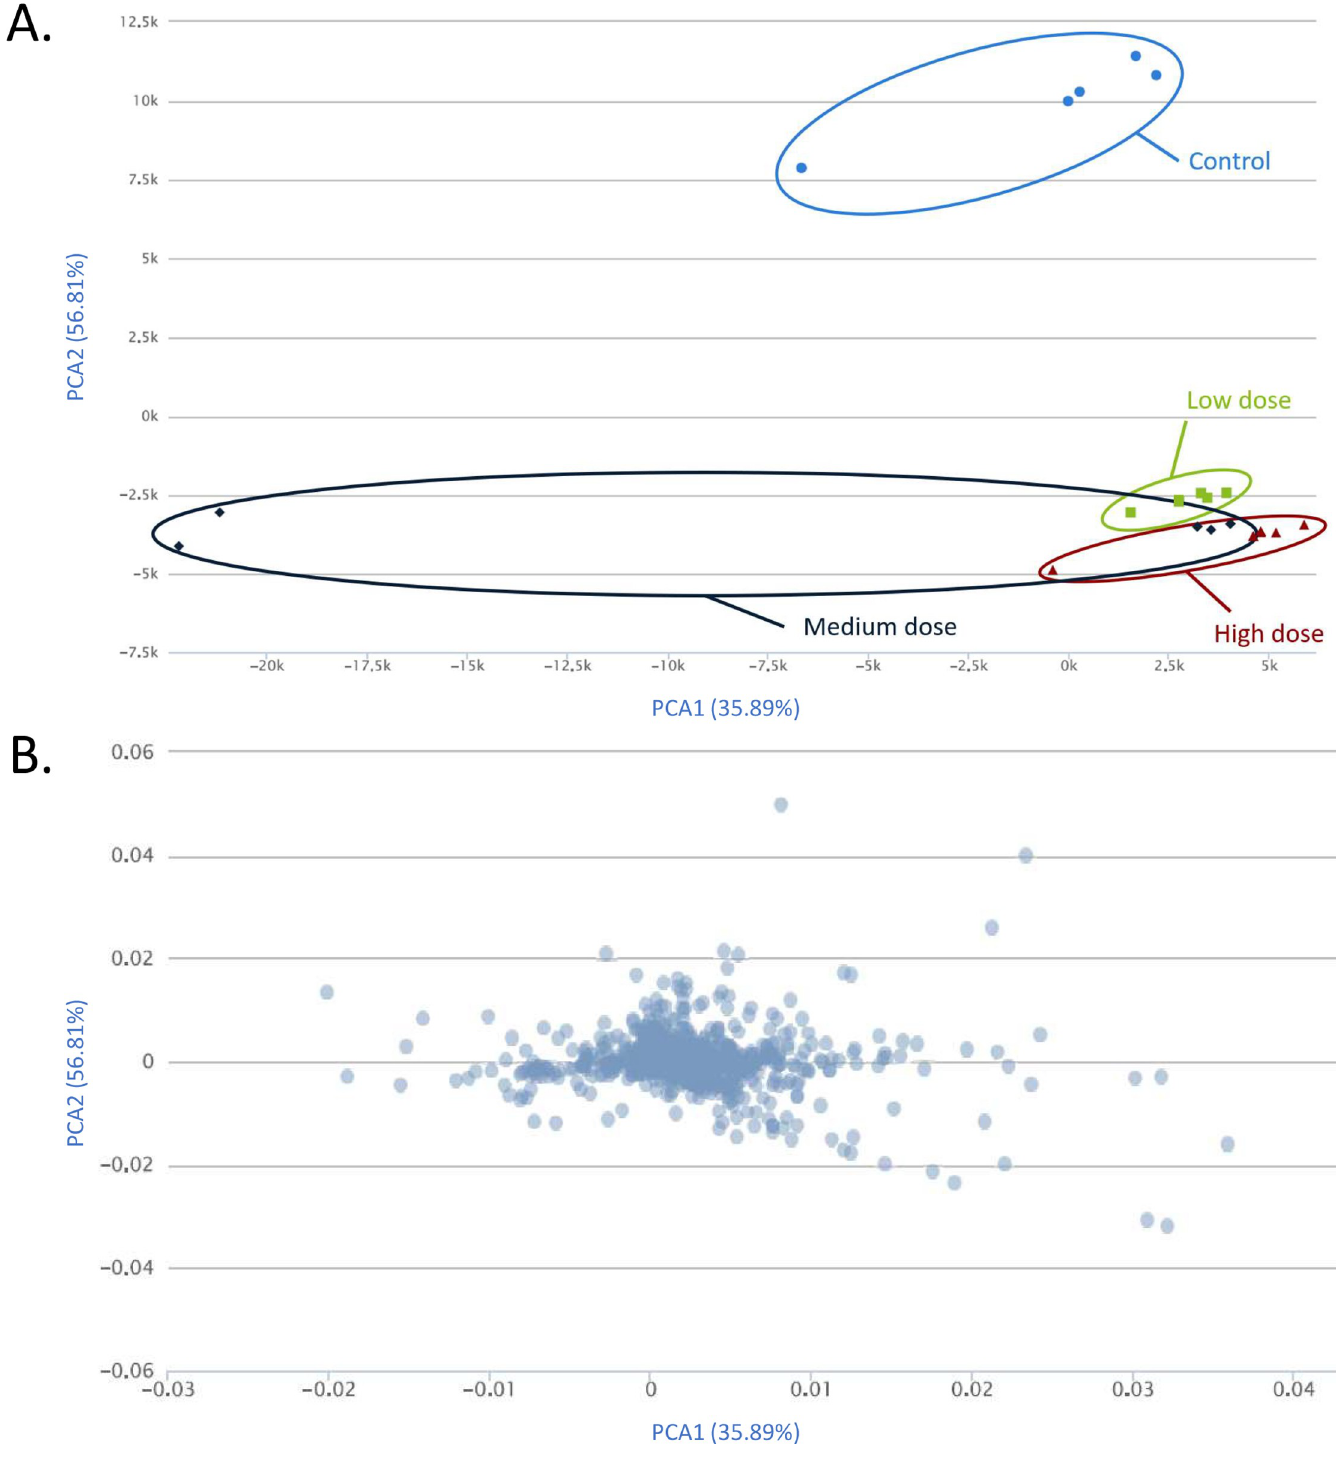
Fig 5. Principal component analysis (PCA) plot of metabolomic data from control, low-, medium-, and high-dose PZQ treatment. (A) PCA score plot. Blue circles represent dataset of control group (Centroid = -506.301, 10080.555). Green squares represent dataset of low-dose PZQ treatment group (Centroid = 3011.11, -2643.879). Black diamonds represent dataset of medium-dose PZQ treatment group (Centroid = -6516.275, -3540.422). Scarlet triangles represent dataset of high-dose PZQ treatment group (Centroid = 4011.466, -3896.345). (B) PCA loading plot.